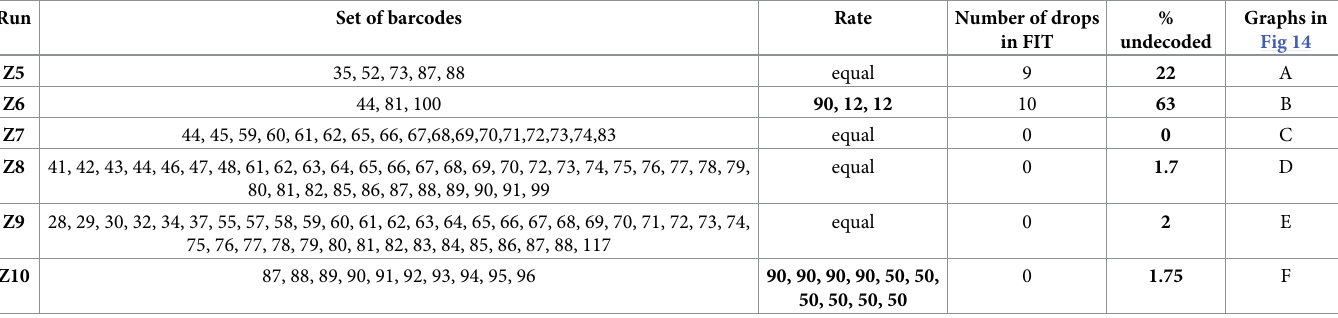
Table 2. Characteristics of PE150 mode runs on MGISEQ-2000 with good and bad quality.